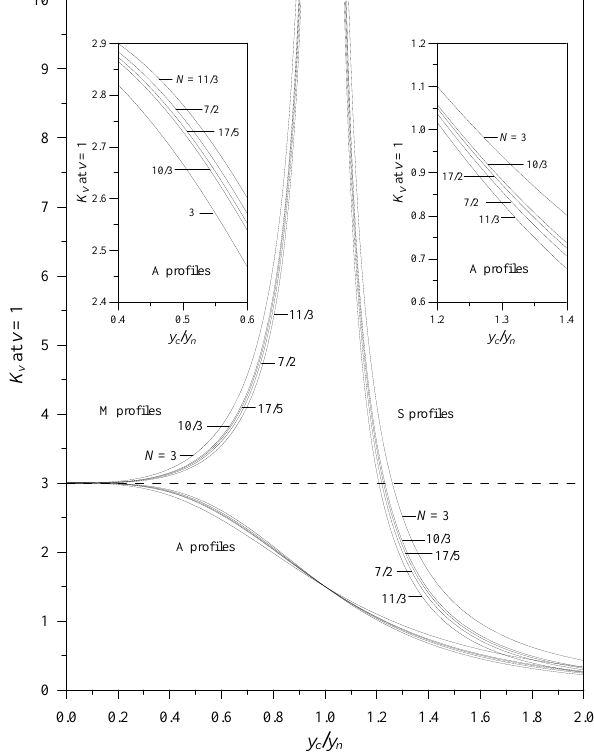
parameter for GVF profiles in sustaining channels and also in adverse channels.